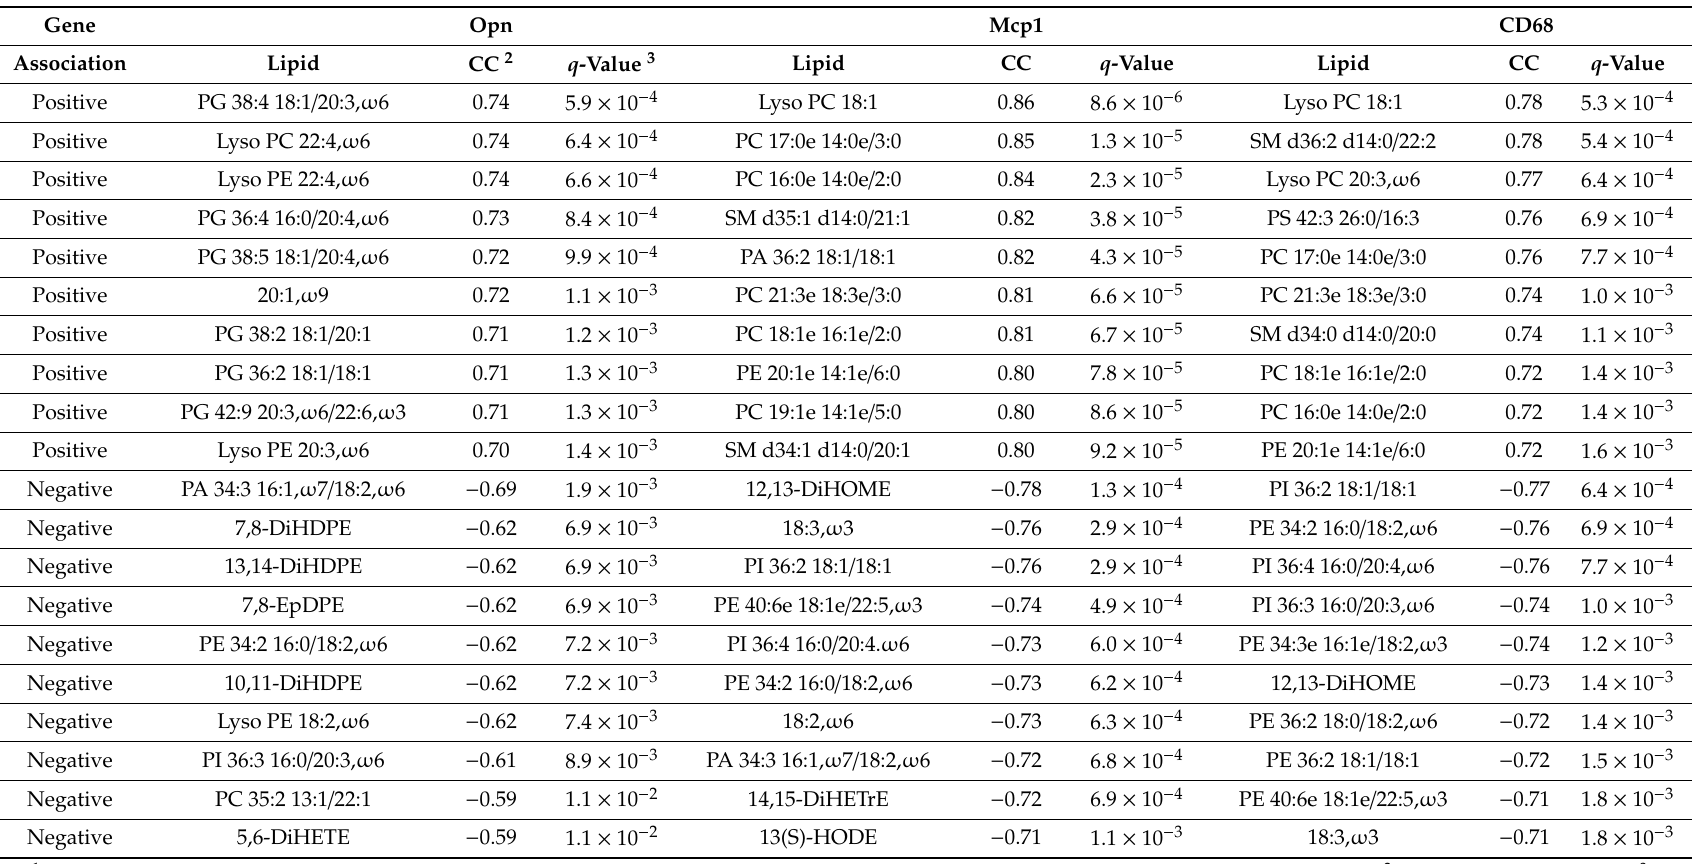
Table 1. Top 10 hepatic lipids positively and negatively associated with hepatic gene expression markers of inflammation 1 .